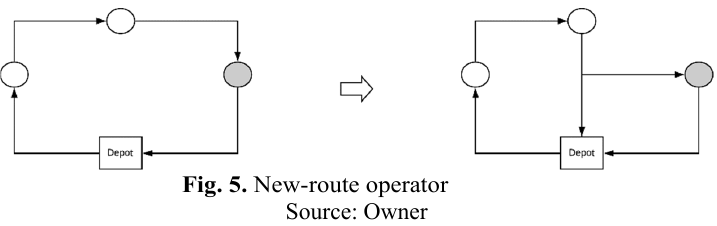
Fig. 5. New-route